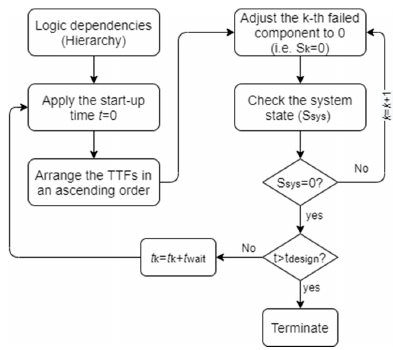
Figure 4. Flowchart illustrating simulation of time of failures (TTFs).